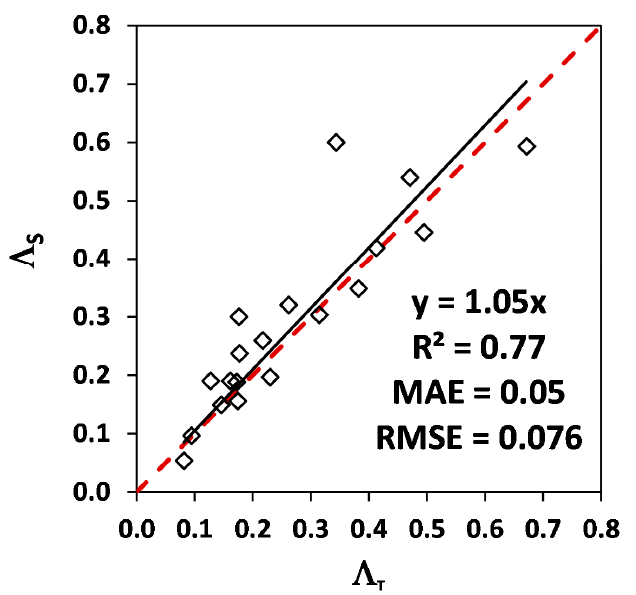
Figure 8. SEBAL-based evaporative fraction ( Λ S ) compared to tower-derived evaporative fractions ( Λ T ). The red dashed line represents t he 1:1 equity line. ( Λ T ). The red dashed line represents the 1:1 equity